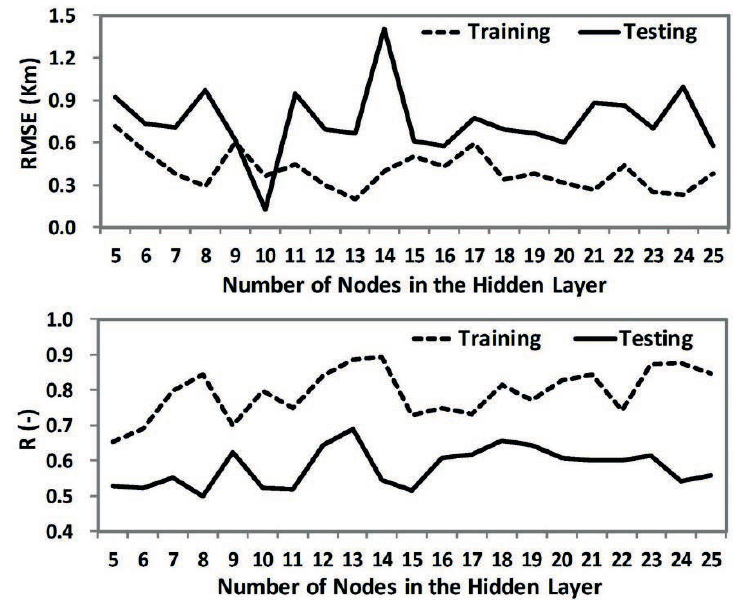
Fig. 1 The RMSE and correlation coefficient (R) of atmospheric visibility estimates for different numbers of nodes in the hidden